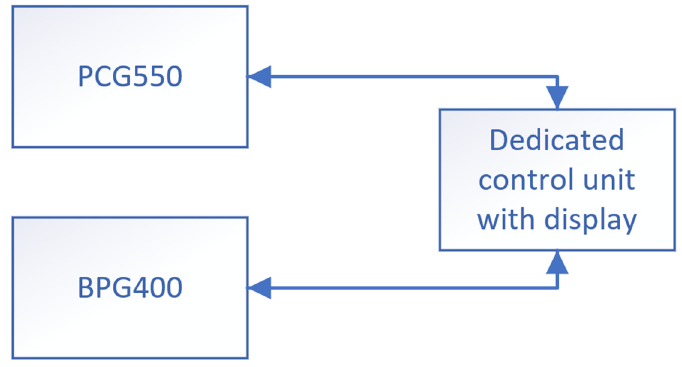
Figure 9. Vacuum probe controller connection.